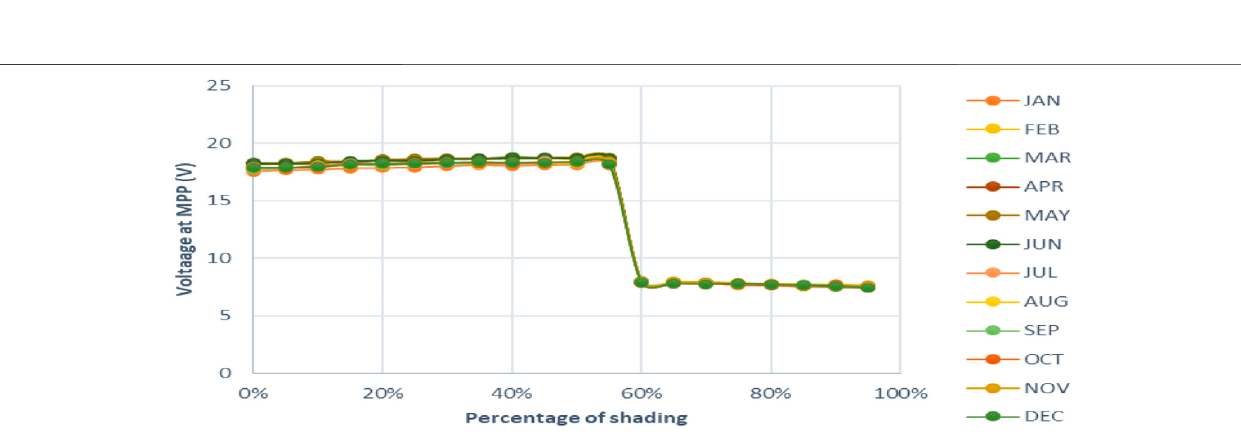
FIGURE 7 | Monthly evolution curve of V mp according to the shading.